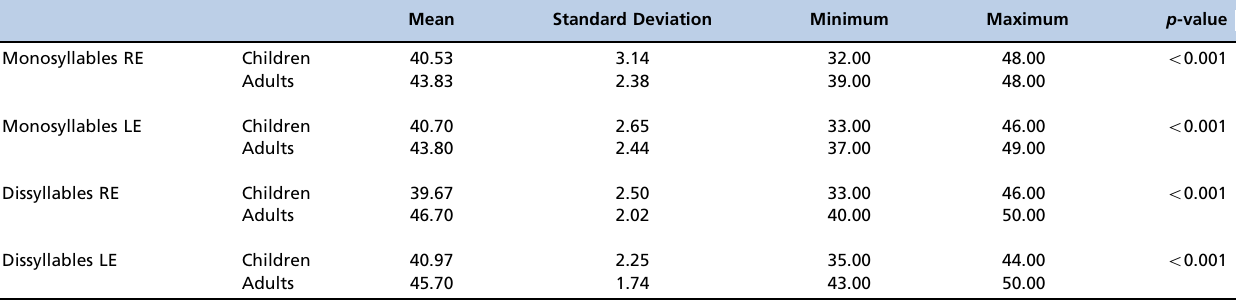
Table 1 - Descriptive analysis of the performance obtained by the group of children and adults in TFC, both for the monosyllabic and the disyllabic modality. Mean